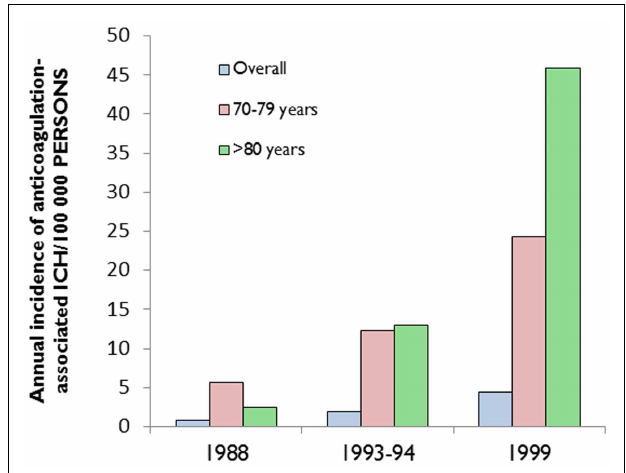
FIGURE 1 |The increasing incidence of anticoagulation-associated intracerebral hemorrhage (ICH), especially in the elderly. Data extracted from (Flaherty et al., 2007).